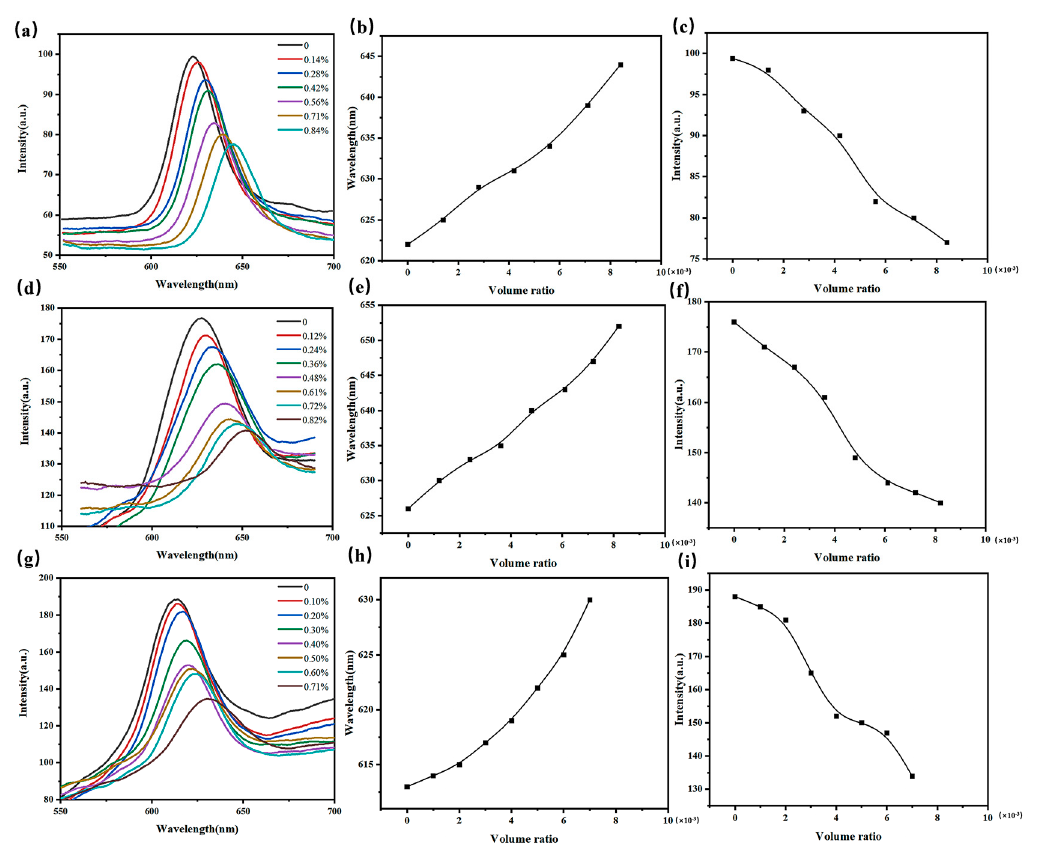
Figure 5. Responses of the 3D O-(A- β -CD)-AM PC to VOC gas. ( a ) λ max responses of 3D O-(A- β -CD)- AM PC to toluene gas; ( b ) the relationship between the wavelength of λ max and volume ratio; ( c ) the relationship between the intensity of λ max and volume ratio of the toluene gas; ( d – f ) λ max responses of 3D O-(A- β -CD)-AM PC to xylene gas; ( g – i ) λ max responses of 3D O-(A- β -CD)-AM PC to acetone gas.